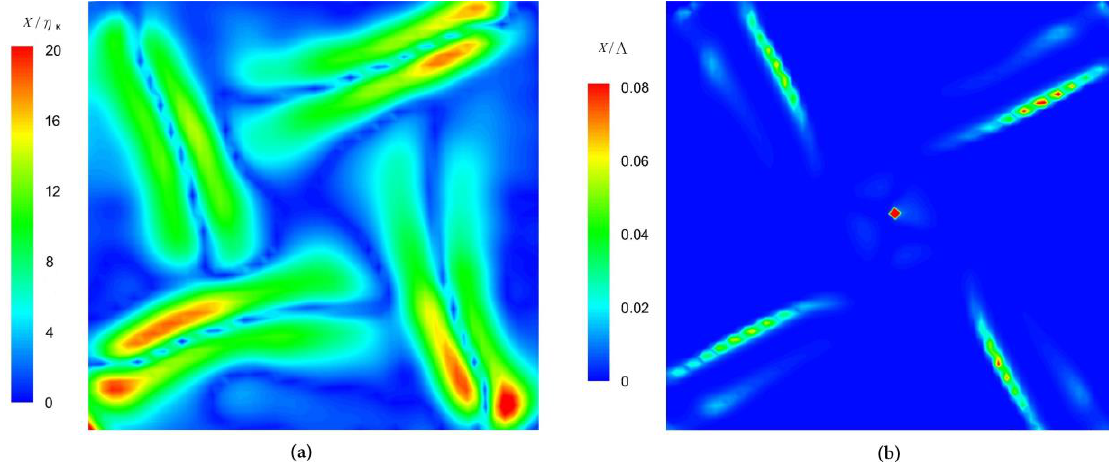
Figure 3. The ratio of PIV spatial resolution (X) to ( a ) Kolmogorov length scale ( η κ ) and ( b ) the integral length ( Λ